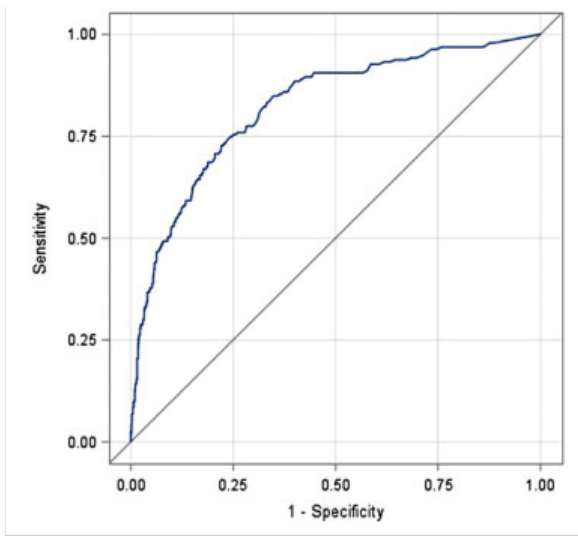
Fig. 4 ROC curve for D-dimer in patients with suspected DVT. The area under the curve was